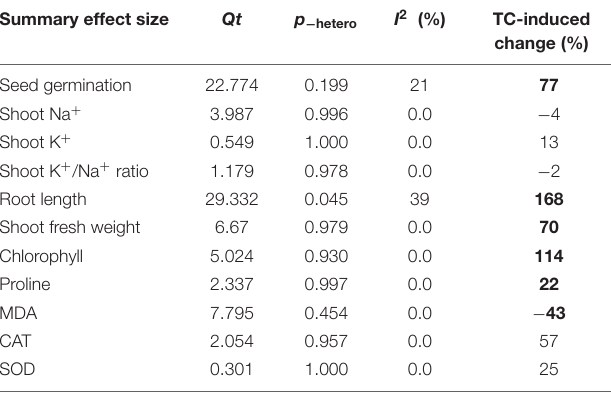
TABLE 1 | Heterogeneity statistics for the 11 summary effect sizes under NaCl stress.